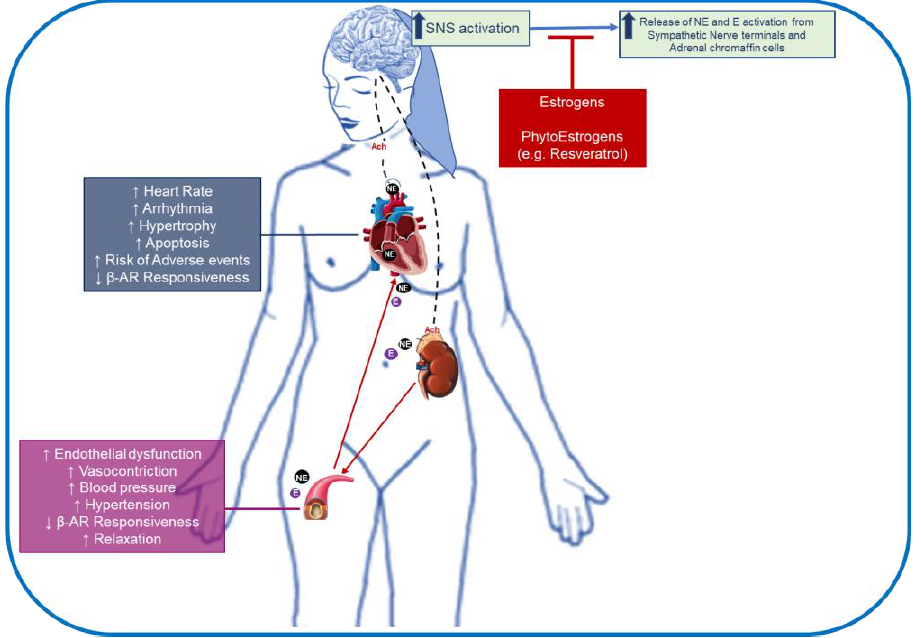
Figure 2. Potential effects of estrogen or phytoestrogen therapy on sympathetic nervous system (SNS) hyperactivity in postmenopausal women . Increased SNS activity in postmenopausal women induces catecholamine secretion from the chromaffin cells of the adrenal medulla (~80% epinephrine (E) and 20% norepinephrine [NE]), or the postganglionic sympathetic fibers (~80% NE and 20% E), resulting in increased circulating catecholamine levels, accelerating the risk of adverse vascular and cardiac effects. Estrogen or phytoestrogen therapies may inhibit SNS overactivation, preserving β - adrenergic receptors (β -Ars) responsiveness and density, and therefore ameliorating most of the cardiovascular disease (CVD) risk factors.